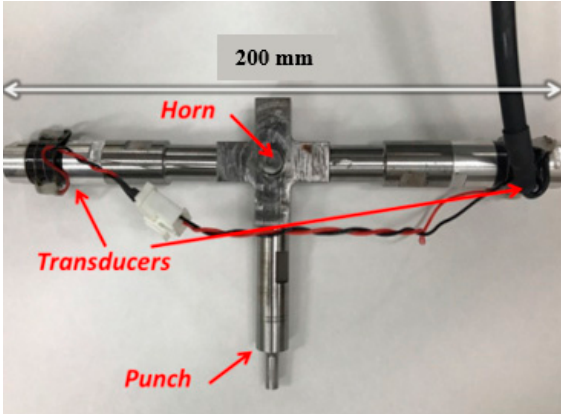
Figure 2. Integrated structure of the ultrasonic vibrator.